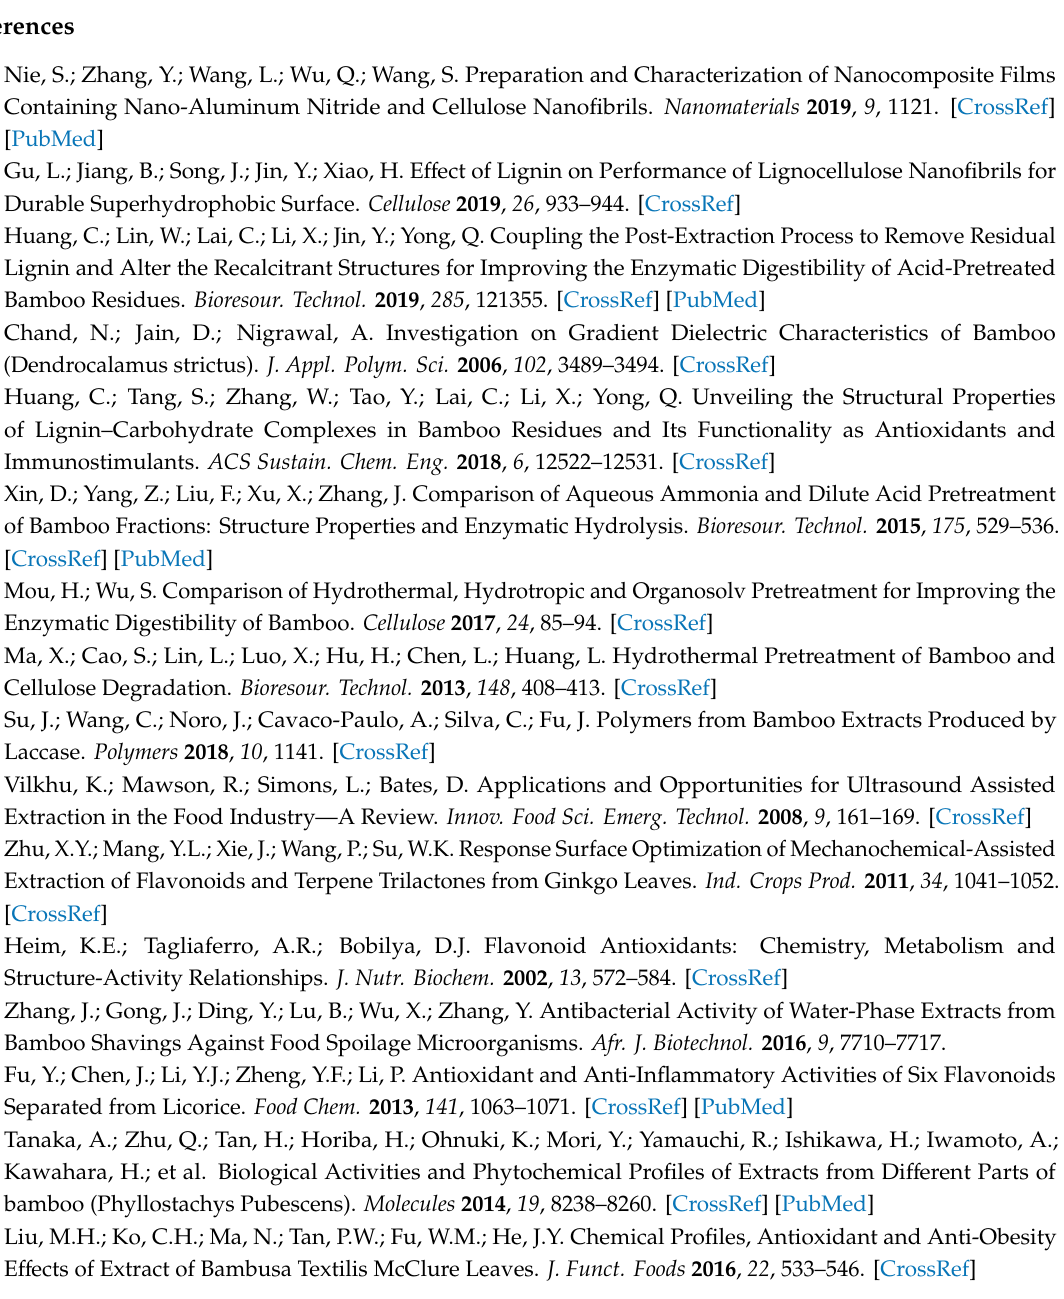
Figure S1. HPLC chromatogram of the BRF detected at 280 nm; Figure S2. LCMS profiles of five standard compounds. From (a) to (e) are isoorientin, isovitexin, pinosylvin, tricin, isorhamnetin; Table S1. Main flavonoids compounds in BRF identified using LCMS